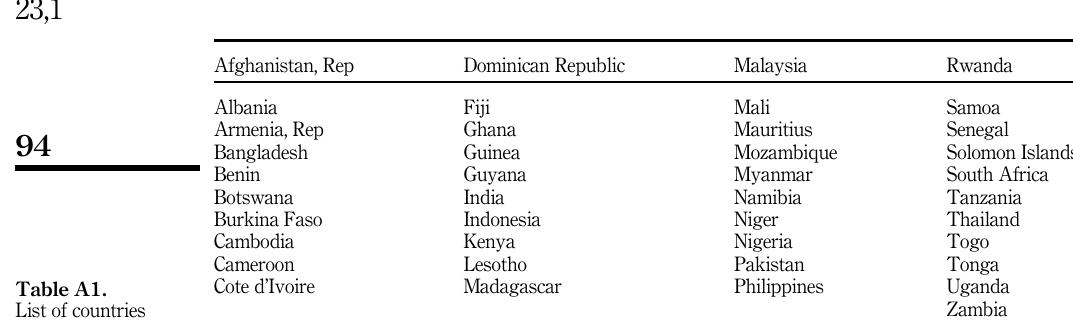
Table A1. List of countries